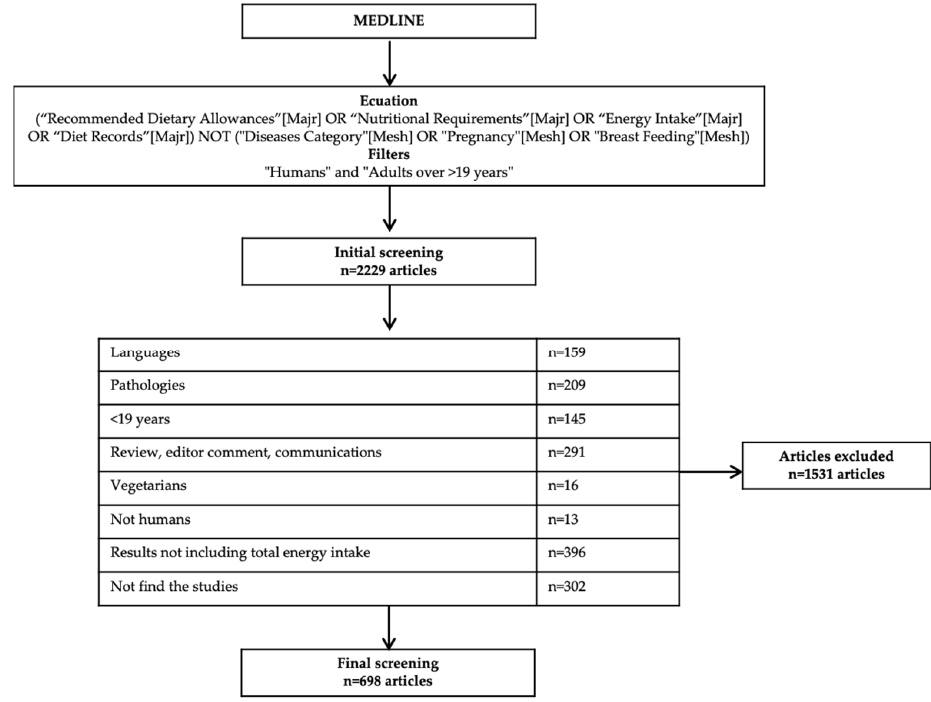
Figure 1. Flowchart of the study selection.